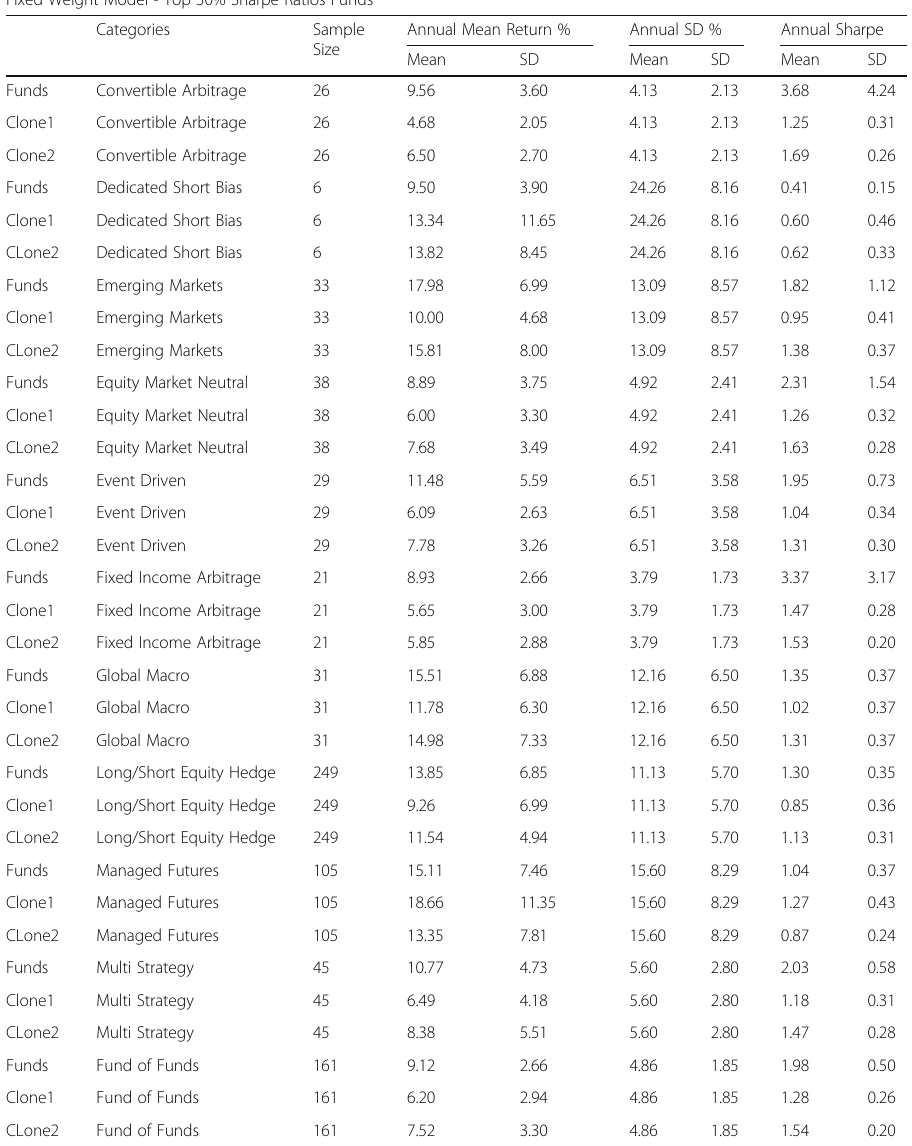
Table 3 Performance comparison for fixed weight model for top 50% Sharpe ratio funds and their